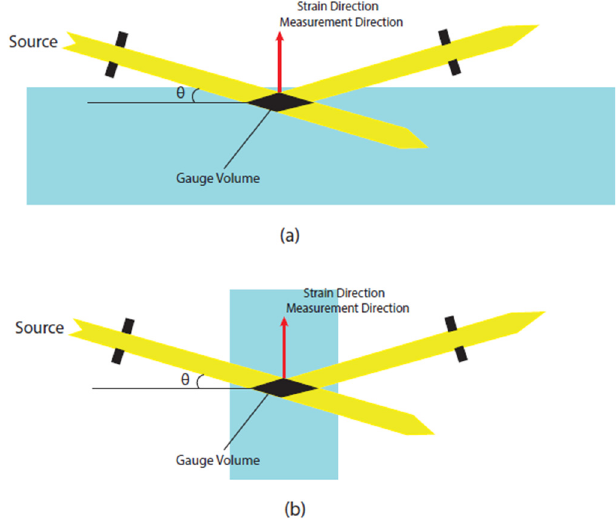
Figure 4. ( a ) Reflection measurement configuration. ( b ) Transmission measurement configuration.